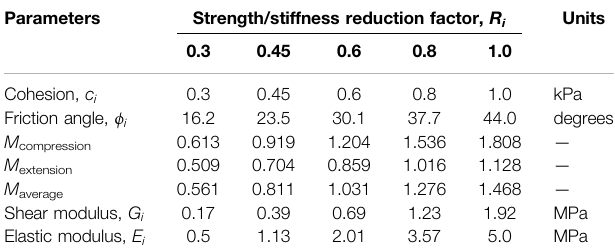
TABLE 2 | Interface properties (related to E soil = 5 MPa).